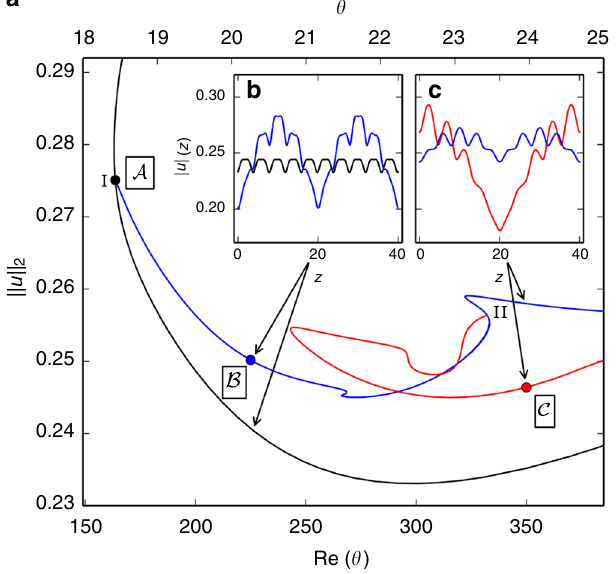
Fig. 5 Phase modulations along the bifurcation sequence. Streamwise dashed contours at ω st = ±0.12) encodes streamwise phase information of wavy streak modulations for equilibria A , B and C along the bifurcation sequence (points in Fig. 4). Red (blue) lines connecting vorticity maxima (minima) represent wave fronts of constant streamwise phase. The Nagata equilibrium A has wave fronts oriented in the spanwise direction. The stripe equilibrium C has sigmoidal wave fronts. In the turbulent region the wave fronts are oriented at θ = 24° (red/blue arrows), and align with the pattern wave vector (in the z -direction). Bottom panel indicates turbulent and laminar regions in C (see also Fig.